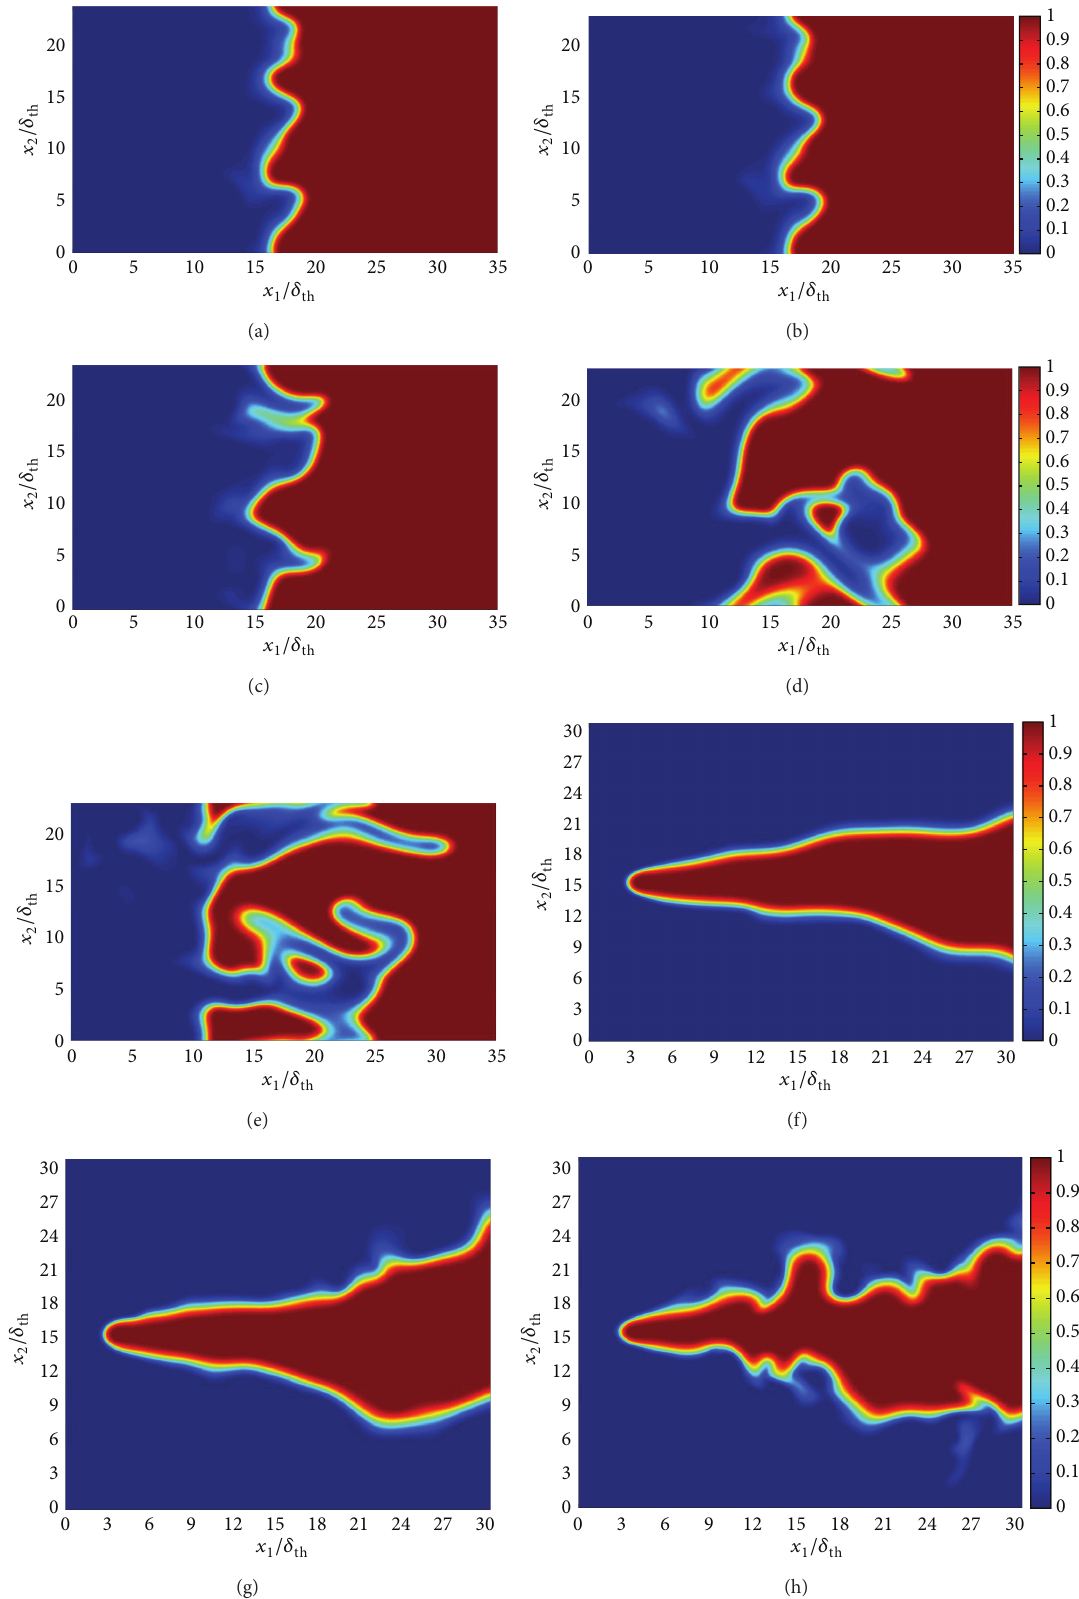
/𝑆 𝐿 and for cases V1–V3 th